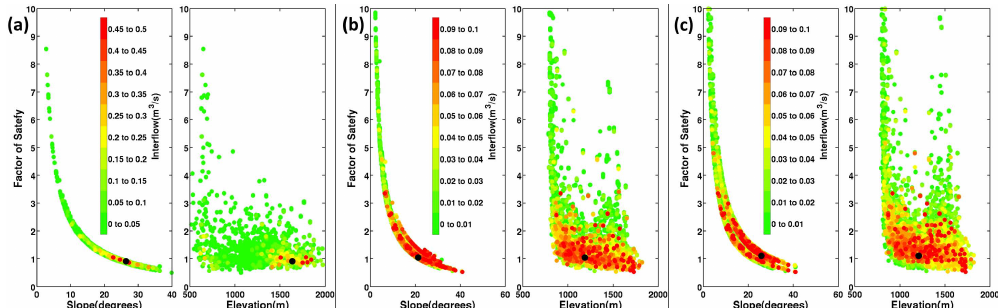
Fig. 12. Scatter plots of the factor of safety (FS) versus slope and elevation for each grid element in the basins during the simulation for the event in July of 2011 (a) , and in January (b) and December (c) of 2009. The circles are colored according to the magnitude of outgoing interflow. The pixel of interest is highlighted by a black